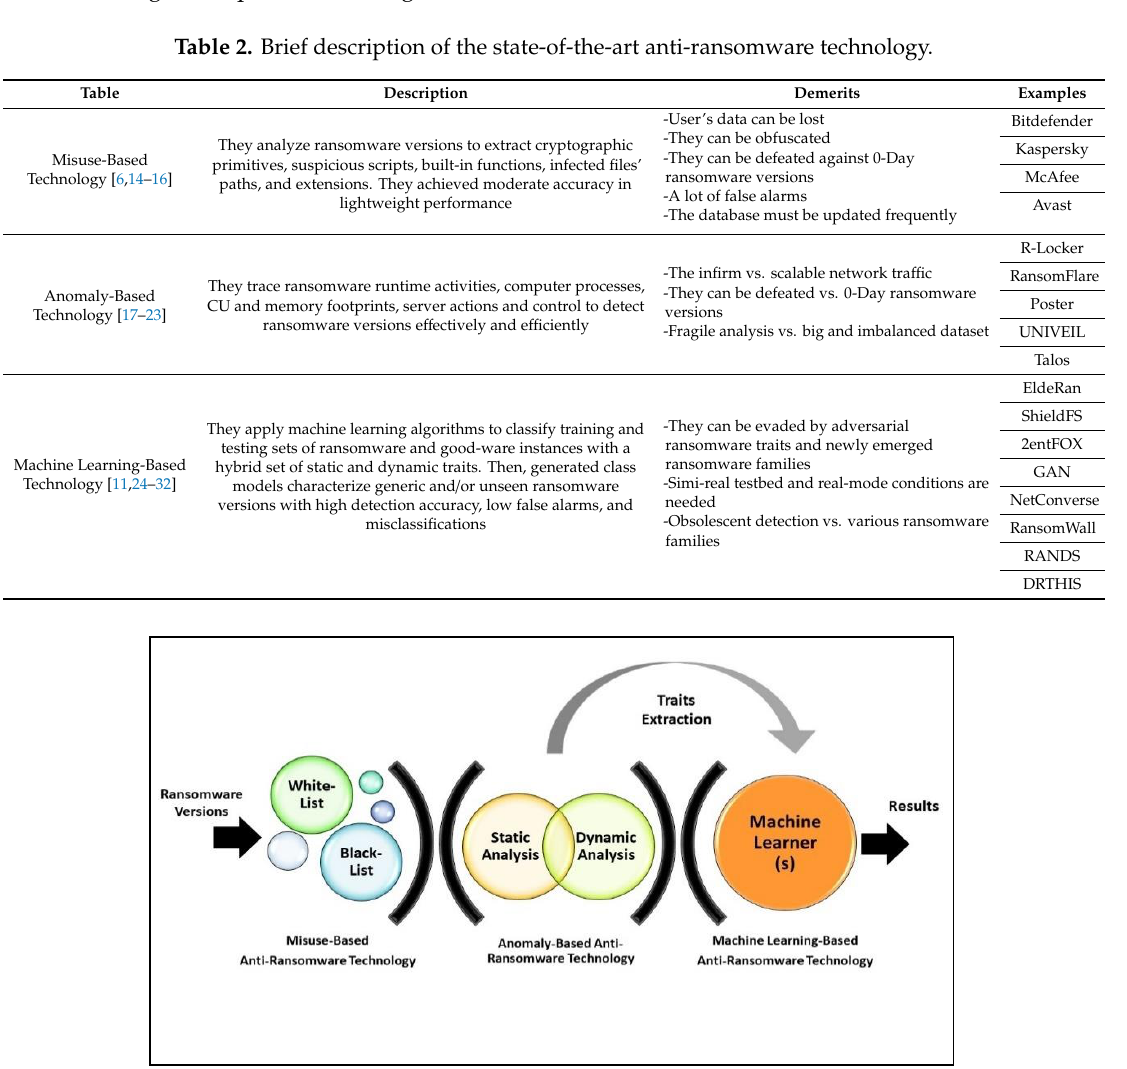
Figure 2. Essentials and appendages of the state-of-the-art anti-ransomware technologies.